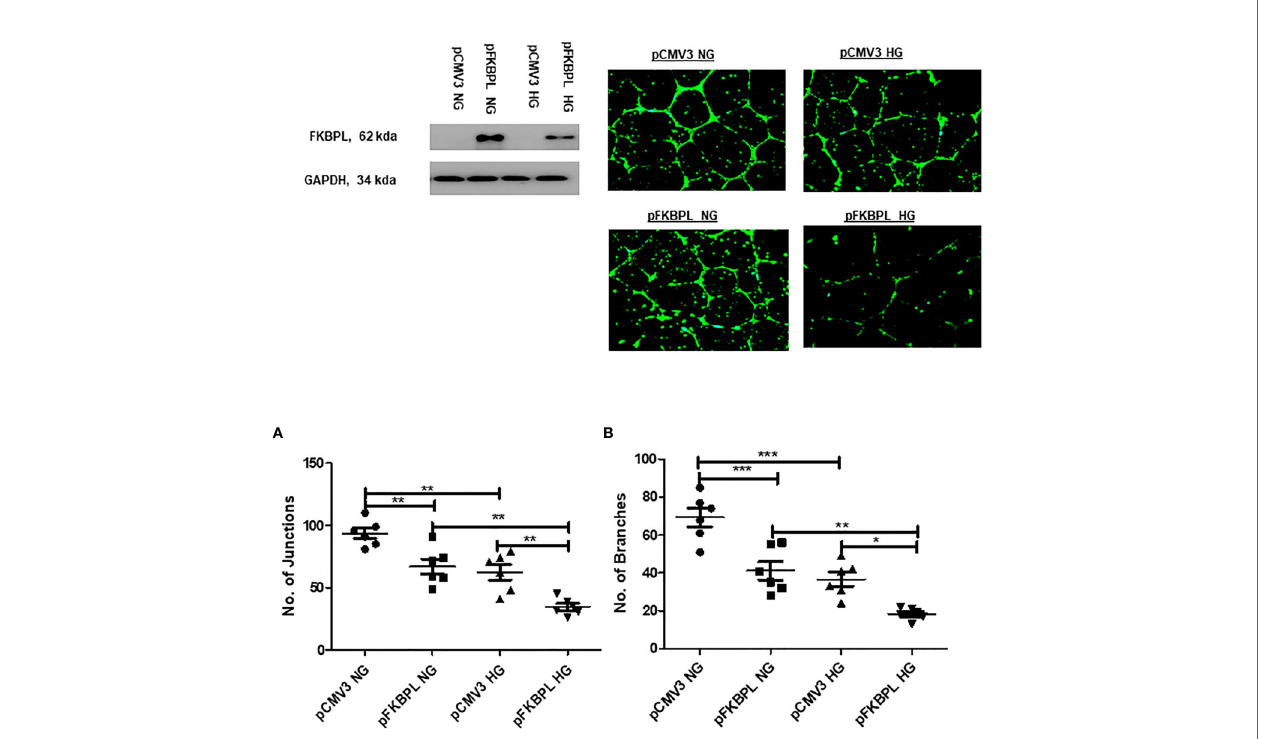
FIGURE 5 | Angiogenic potential is further reduced with FKBPL overexpression in high glucose conditions in HUVECs. The number of (A) junctions and (B) branches was quanti fi ed following FKBPL overexpression in HUVECs for 24 h. The cells were stained with calcein stain, before being plated in Matrigel and exposed to high glucose (HG, 30 mM) or normal glucose (NG, 5.5 mM) media for 24 h. Six images/well were taken using a DMi8 microscope; representative images are shown inset. Images were analysed based on the number of junctions and branches formed using ImageJ angiogenesis macros. (n=6, *<0.05, **<0.01, ***<0.001, One-way ANOVA, followed by Bonferroni multiple comparison